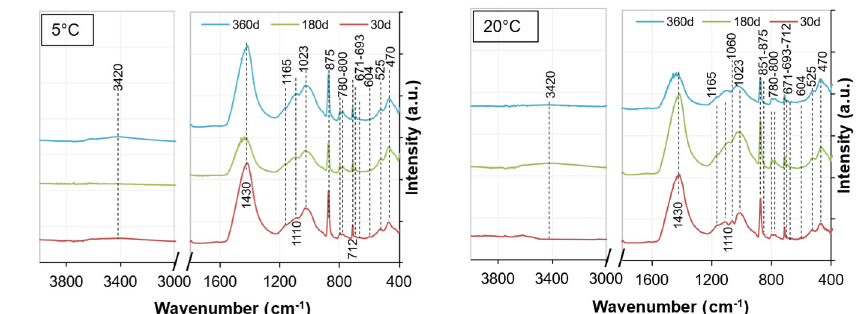
Figure A11. FTIR results of S + C + W1.